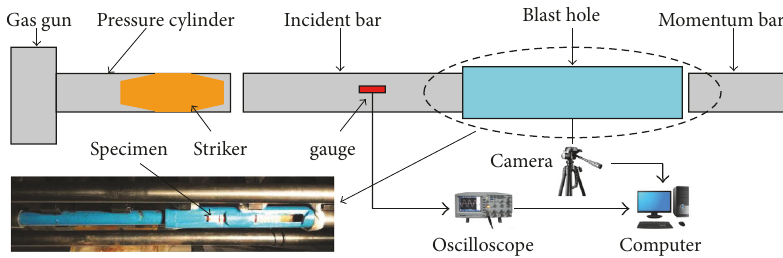
Figure 3: Schematic diagram of Hopkinson bar structure improvement in the blocking impact test.